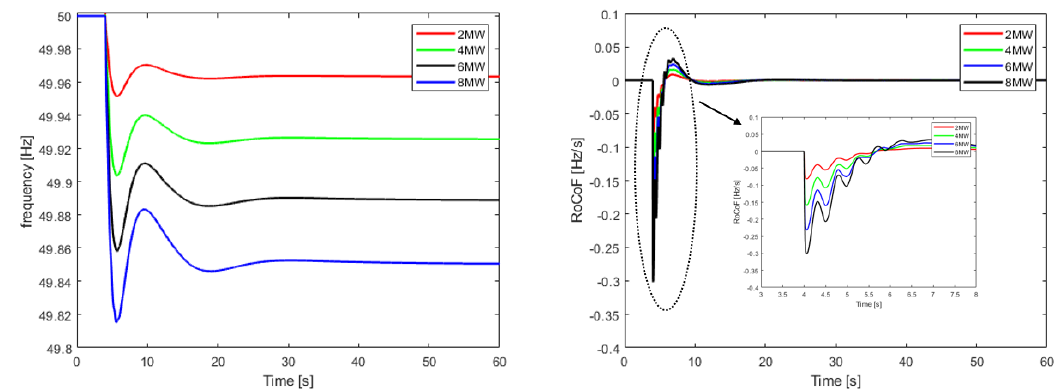
10 of 26 Figure 6. Madeira’s power system model in Modelica/Dymola. 6.1. Disturbances Three types of disturbances have been examined, namely (i) load step-change, (ii) generation loss and (iii) short-circuit at the transmission level. The purpose of this section is to illustrate the differences between the future and reference scenarios and demonstrate that the increase of vRES penetration affects network stability and requires solutions to avoid curtailment while maintaining power system security and reliability. 6.1.1. Load Step-Change To examine the transient behavior of the system under stiff load changes, four simulations are presented, parameterized by the value of the load step increase, i.e., 2 MW e , 4 MW e , 6 MW e and 8 MW e . Figures 7 and 8 show the frequency response and RoCoF for the best and worst cases of the reference scenario, respectively. It can be observed that the system responded successfully to this disturbance and no load-shedding relay activation was required as the load-shedding criteria were